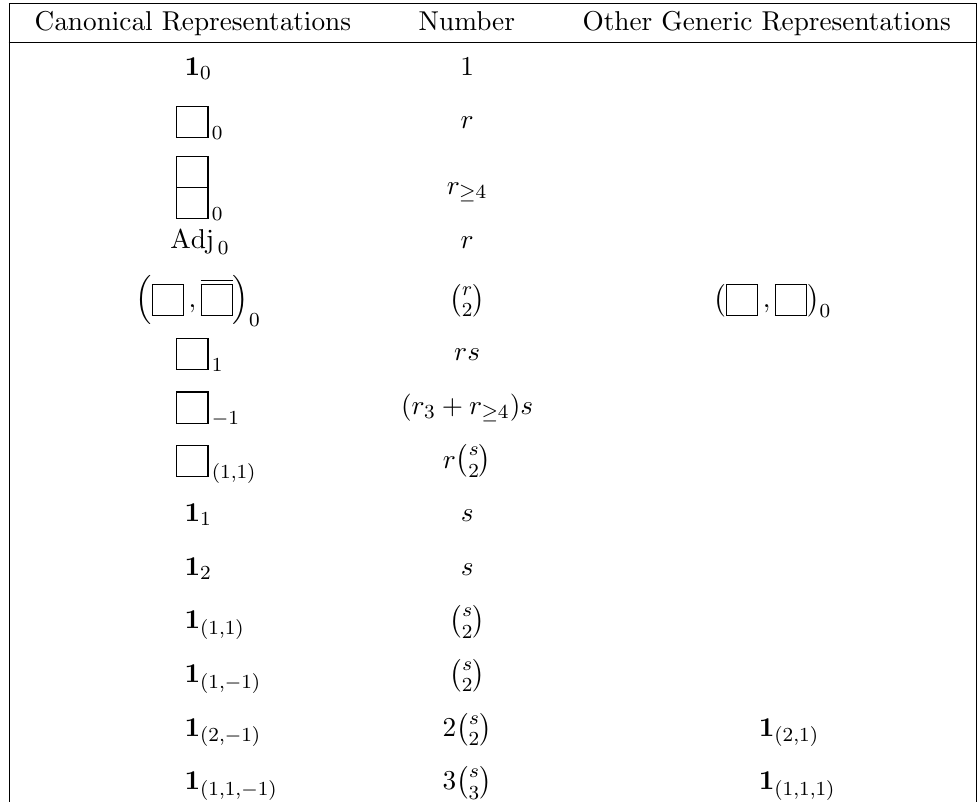
Table 2 . Generic matter representations for gauge groups G = SU( N 1 ) (cid:2) (cid:1) (cid:1) (cid:1) (cid:2) SU( N r ) (cid:2) U(1) s with s (cid:20) 3, along with the number of distinct (canonical) representations of each type. Here, r 2 , r 3 , and r (cid:21) 4 are the number of SU( N ) factors in G with N = 2, N = 3, and N (cid:21) 4, respectively, with r = r 2 + r 3 + r (cid:21) 4 . Note that for some (cid:12)elds charged under multiple gauge factors, the (cid:12)elds in the (cid:12)rst column are canonical choices and there are other \locally equivalent" generic matter representations, as discussed in section 3.4; such further generic matter representations are listed in the third